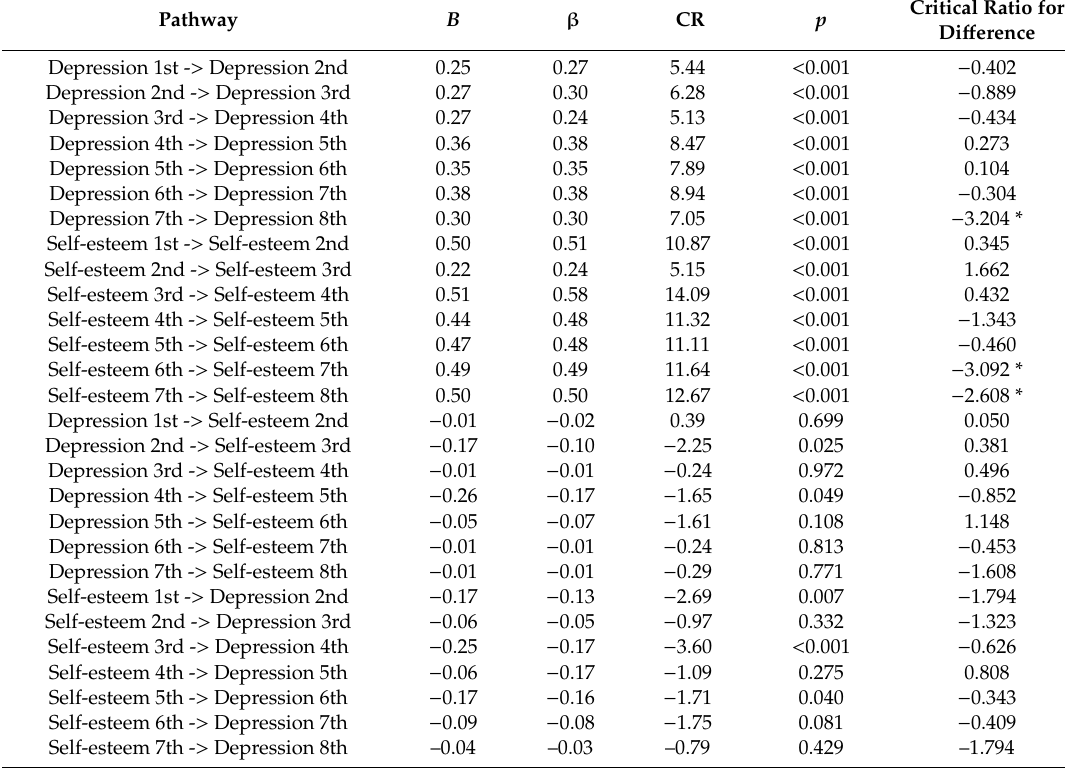
Table 5. Parameter estimation of the relationship between depression and